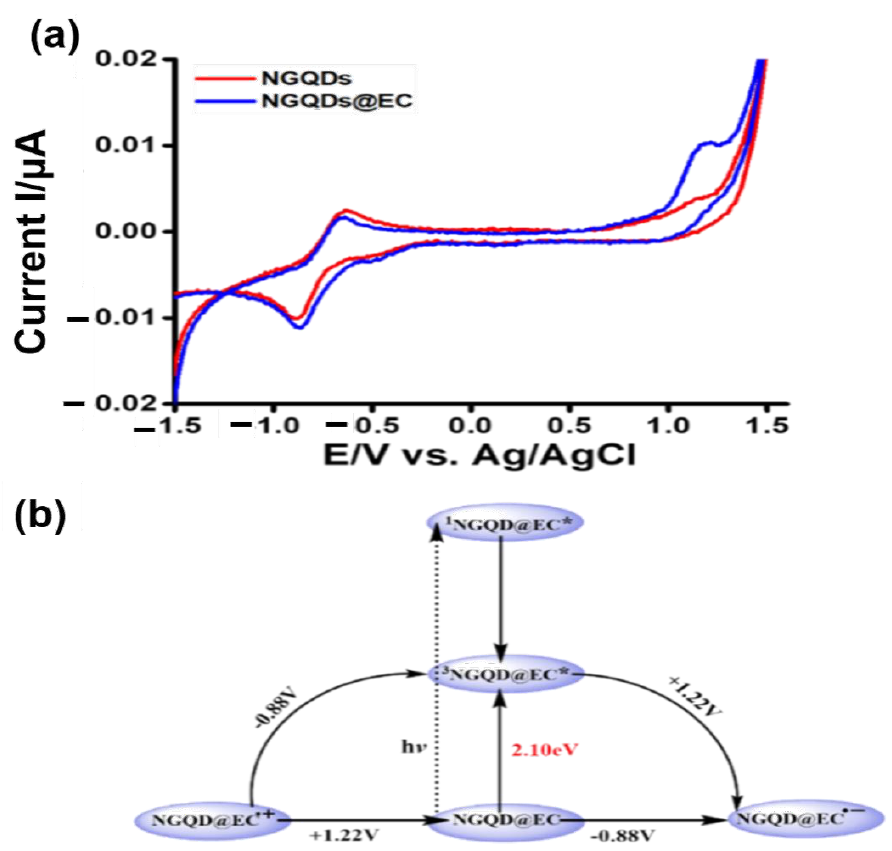
Figure 2. (a ) Cyclic voltammetry (CV) of NGQDs (red line) and NGQDs@EC (blue line) photocatalyst, respectively, ( b ) Latimer diagram of NGQDs@EC photocatalyst.